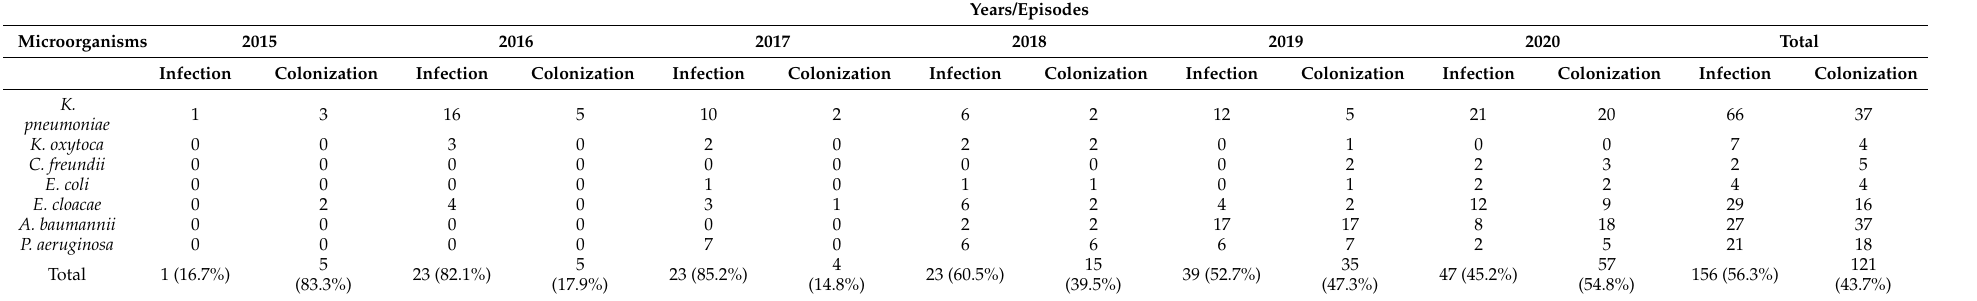
Table 1. Colonization/infection episodes of each carbapenemase-producing bacteria in each year.